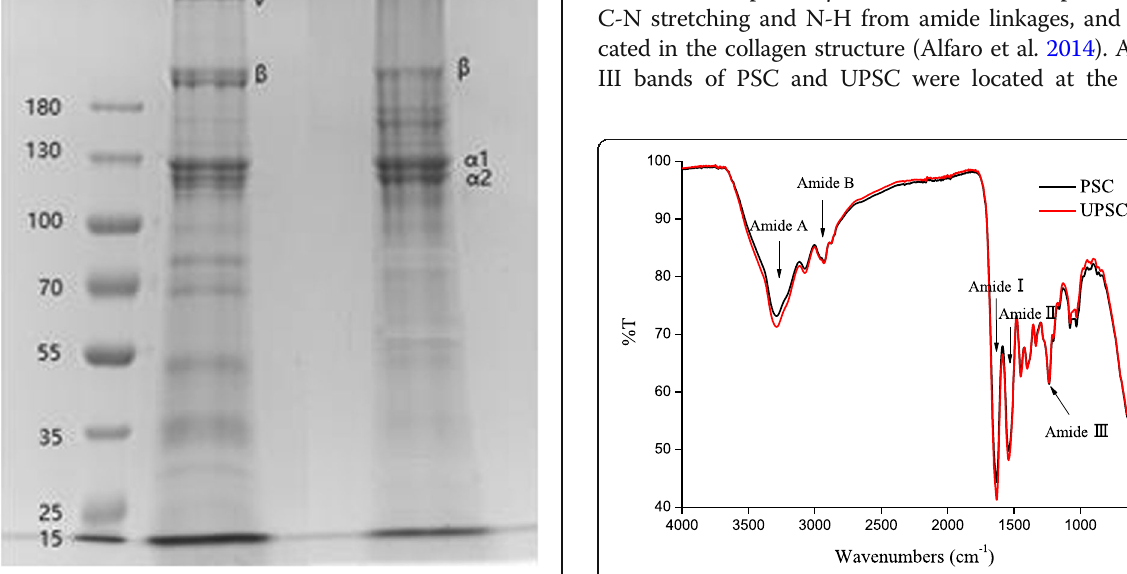
Fig. 2 Sodium dodecyl sulfate-polyacrylamide gel electrophoresis (SDS-PAGE) patterns of PSC and UPSC from chicken lung